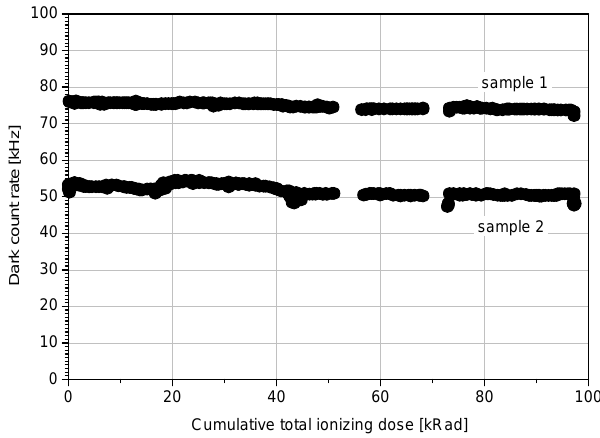
Figure 9. Dark count rate stability of two selected K14 100 µm diodes while irradiated. Note two different dark count rate values demonstrating variation in dark count rate sample by sample whereas it is independent on imposed radiation dose.